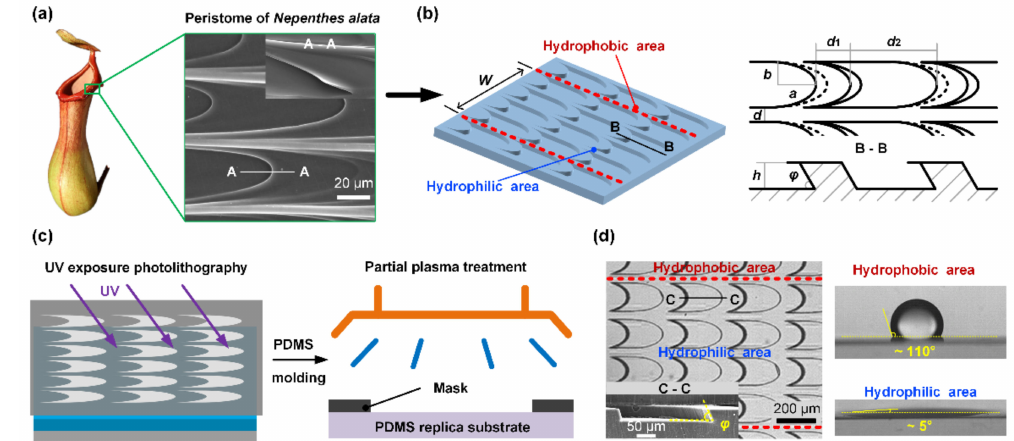
Figure 1. ( a ) Multilevel structures of the natural peristome surface of Nepenthes alata , involving hierarchical microgrooves and duck-billed microcavities. ( b ) Design of the surface-tension-confined (STC) unidirectional liquid spreading channel and biomimetic microcavities. ( c ) Schematic of the channel fabrication process. ( d ) Characterization of the STC unidirectional liquid spreading